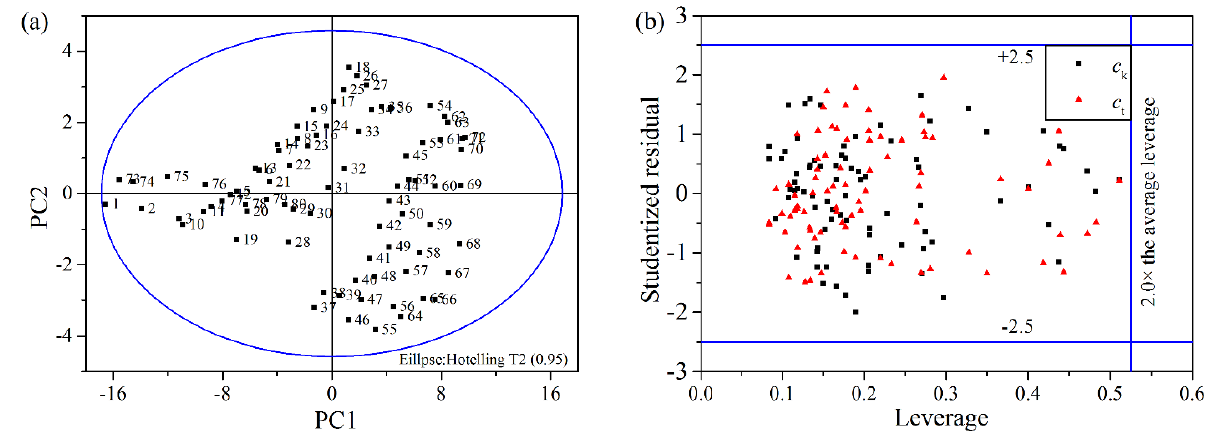
Figure 4. ( a ) The scatter plot of principal components (PC1/PC2); ( b ) The scatter plot of the leverage and the studentized residual.